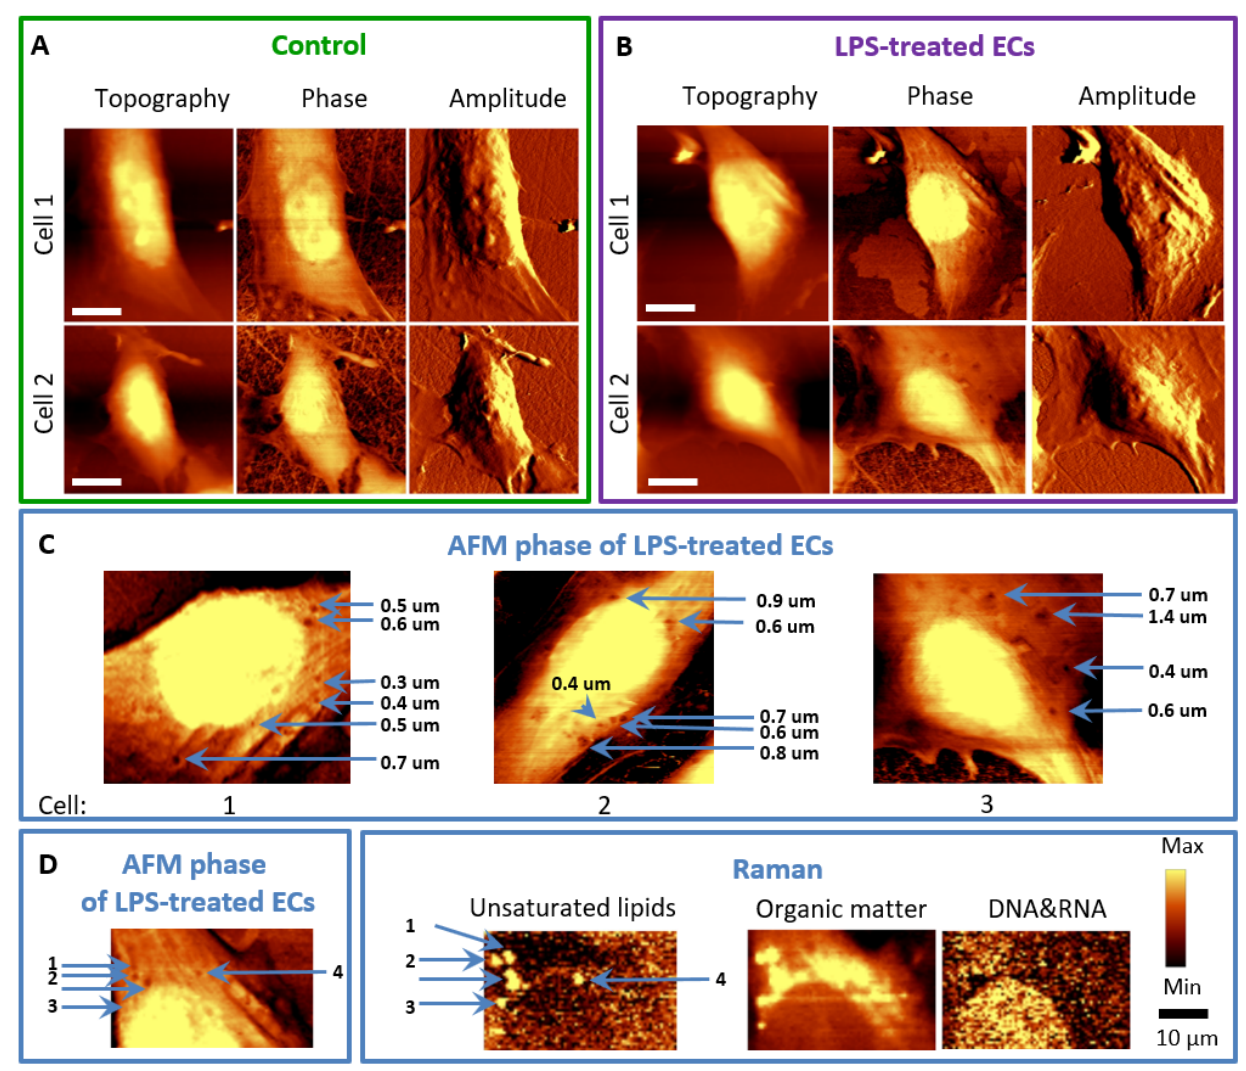
Figure 3. AFM and Raman imaging of endothelial cells incubated with LPS. Representative images of the topography, phase, and amplitude of control HMEC-1 cells ( A ) and stimulated with LPS at a concentration of 10 µ g · mL − 1 for 24 h ( B ). The arrows ( C ) indicate the locations of concaves in the phase images of LPS-treated cells. Phase and topography AFM image as well as Raman images showing co-localized changes in the cell membrane and inside of the cell ( D ).